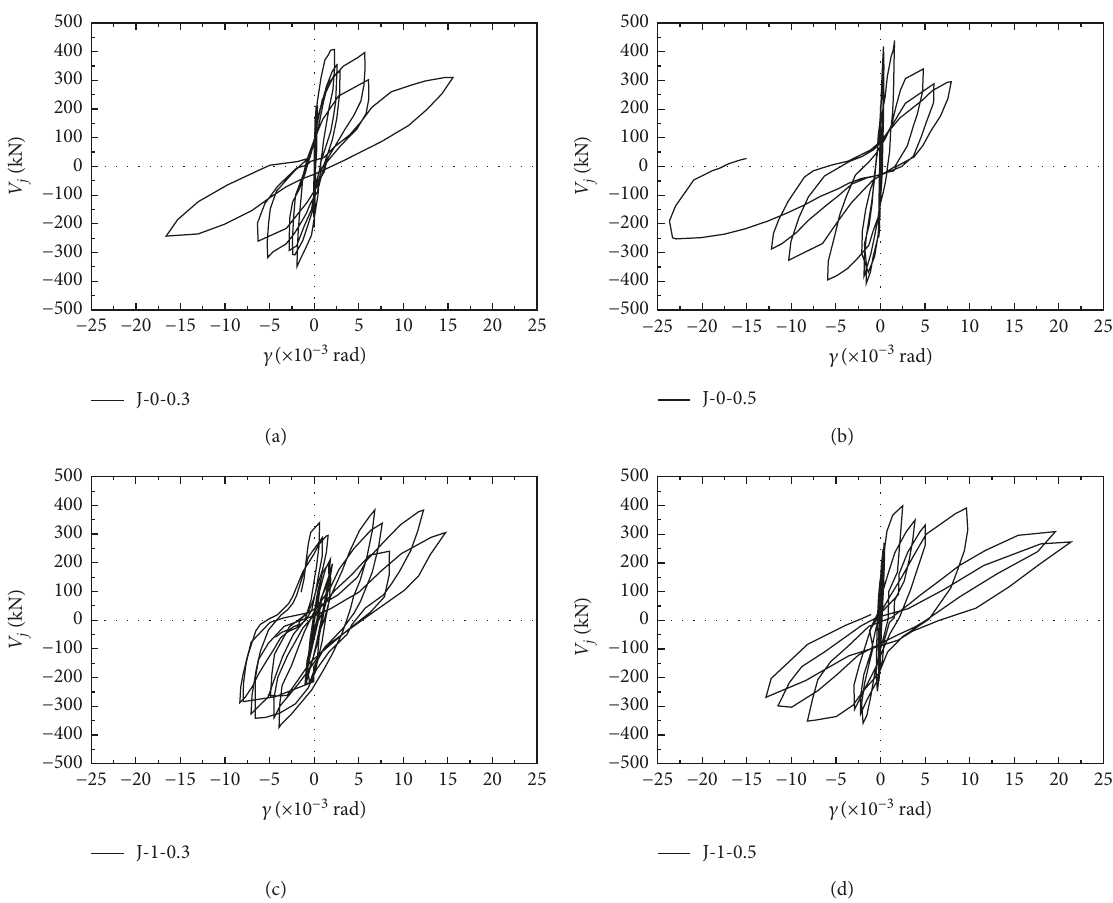
Figure 8: Shear force versus shear deformation angle of joints core. (a) Specimen J-0-0.3. (b) Specimen J-0-0.5. (c) Specimen J-1-0.3. (d) Specimen